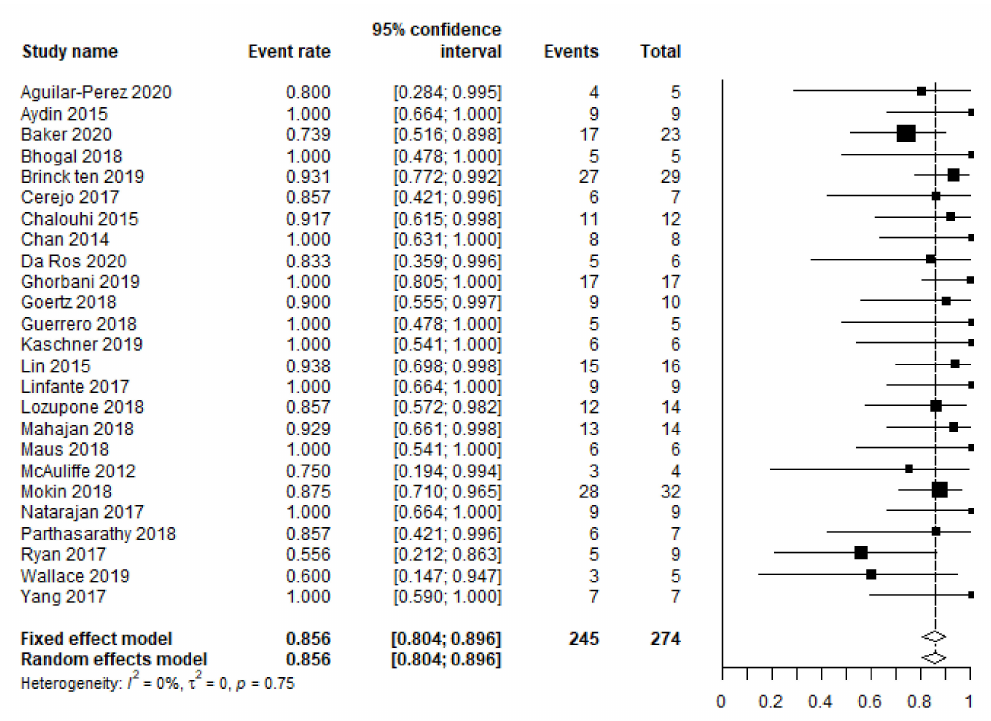
Figure 3. Meta-analysis of the complete occlusion